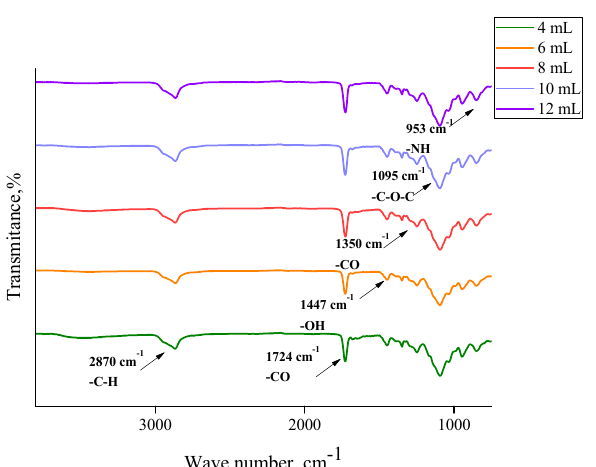
Figure 3. FTIR spectra of materials with different contents of crosslinking agent PEGDA 575.